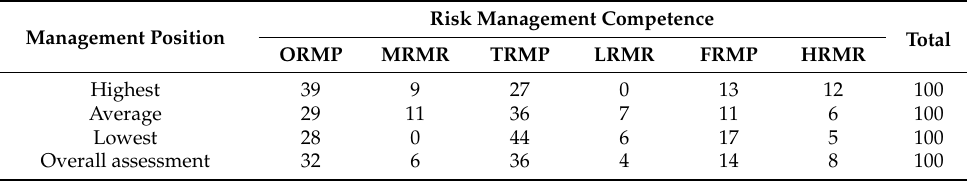
Abbreviations are as defined in Table